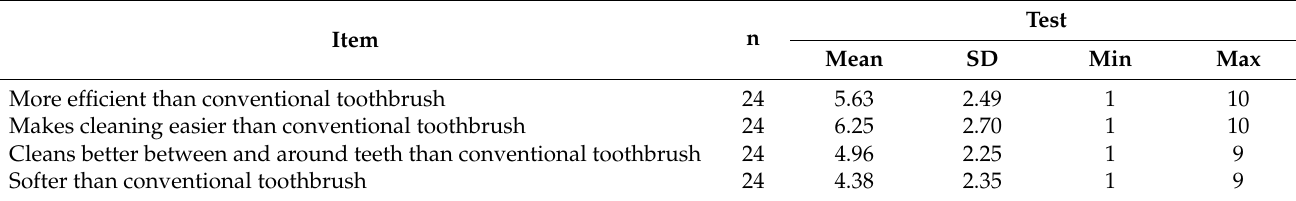
Table 7. Mean, standard deviations (SD) and minimum (Min) and maximum (Max) scores of the evaluation of the test toothbrush at the end of the study (patient-reported outcome measures). The answers were provided on a 1–10